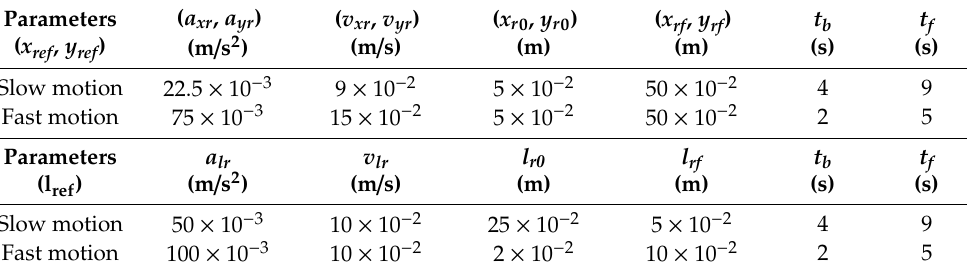
Table 2. Reference Trajectory Parameters.